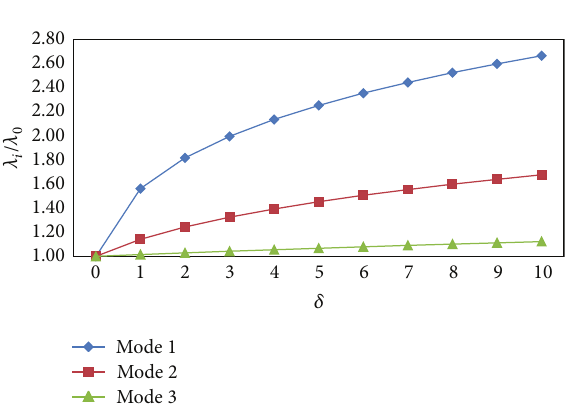
Figure 5: Effect of elastic foundation parameter on the vibration frequencies for 𝑆 0 = 10 5 , 𝑆 𝐿 = 10 , Ω 0 = 10 5 , and Ω 𝐿 = 10 .